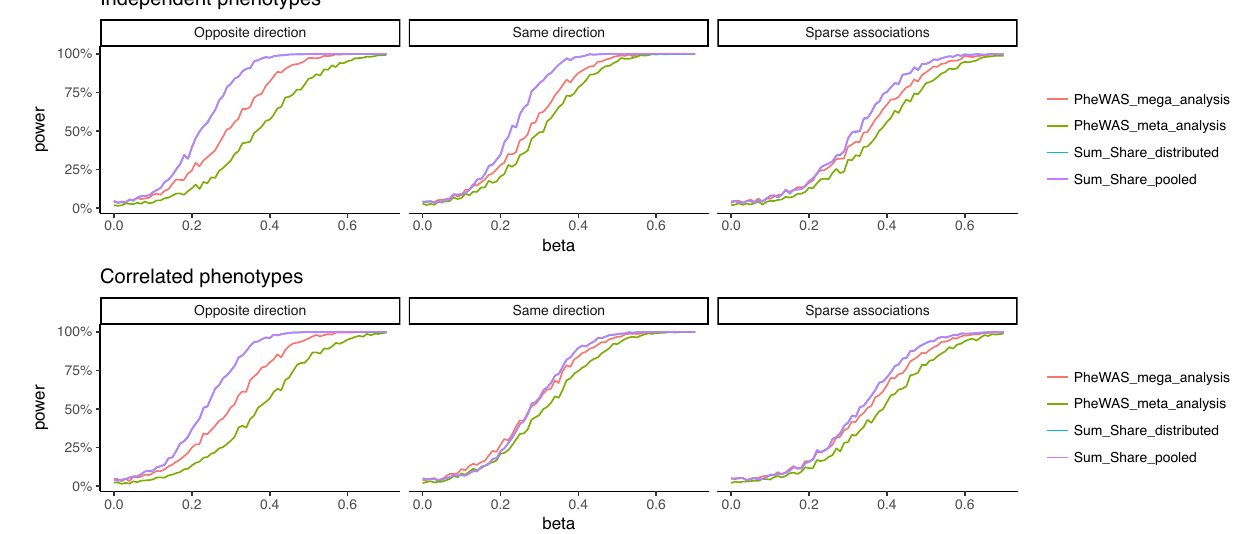
Fig. 2 Power comparisons between Sum-Share and PheWAS. The phenotypes have ~40% prevalence and the SNP has a minor allele frequency of ~5%. The phenotypes and the SNP could have one of the three types of associations: opposite direction, same direction, and sparse associations. The phenotypes are independent (top panel) or correlated (bottom panel). Across beta values (association strength), power was compared between Sum- Share and PheWAS. Power was calculated as the percentage of times a method identi fi ed true signi fi cant associations out of 1000 repetitions. (Note: the blue line overlaps with the purple line).